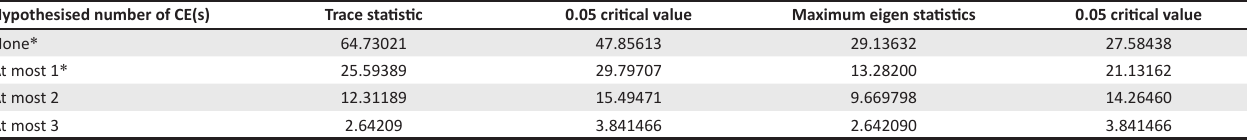
TABLE 3: Cointegrating relations. Hypothesised number of CE(s)